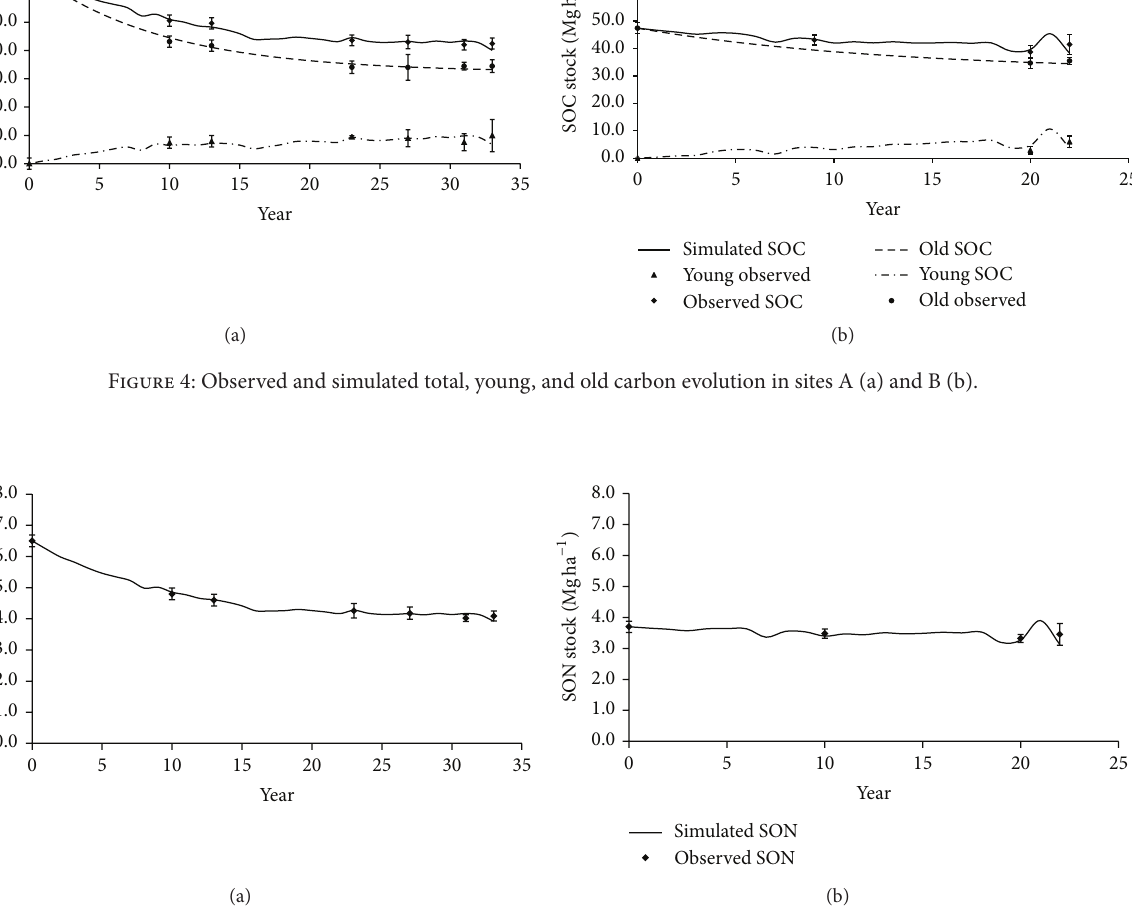
Figure 5: Observed and simulated SON evolution in sites A (a) and B